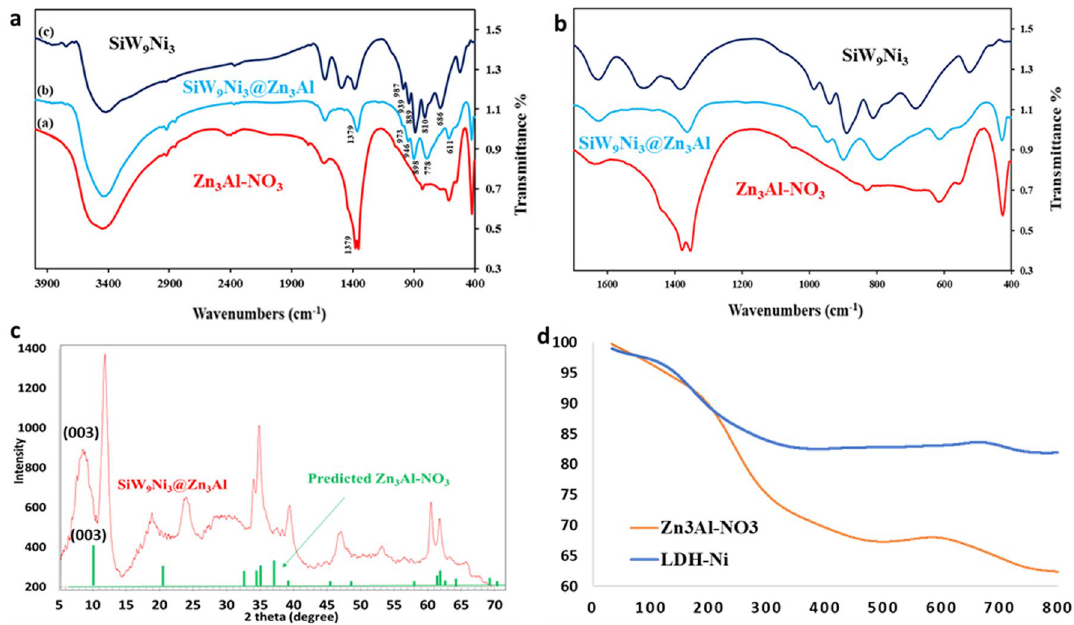
Figure 3. ( a , b ) FT-IR spectra of Zn 3 Al–NO 3 , SiW 9 Ni 3 @Zn 3 Al and SiW 9 Ni 3 ; ( c ) XRD pattern of Zn 3 Al–NO 3 and